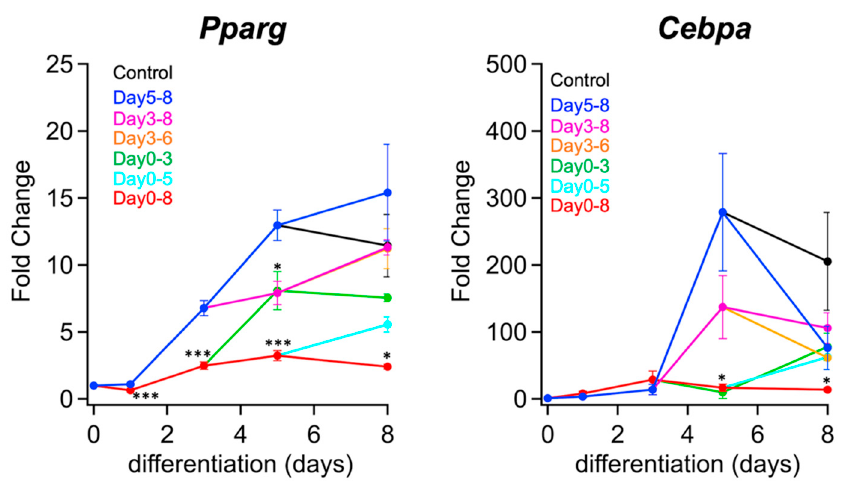
Figure 3. Inhibition of PPM1D in the early stage of differentiation affected by the expression of adipogenic transcription factors. The mRNA expression levels of Pparg and Cebpa under each condition. The mRNA expression of the indicated genes was measured using RT-qPCR. Black line, without SL-176 (Control); red line, with SL-176 during days 0–8; green line, with SL-176 during days 0–3; cyan line, with SL-176 during days 0–5; orange line, with SL-176 during days 3–6; magenta line, with SL-176 during days 3–8; blue line, with SL-176 during days 5–8. The data was normalized by actin mRNA expression and expressed as fold change. Values are presented as the mean ± S.E.M. of three independent experiments. Significance was analyzed by using one-way ANOVA with a post hoc Tukey’s multiple-comparison test. * p < 0.05, *** p < 0.001.